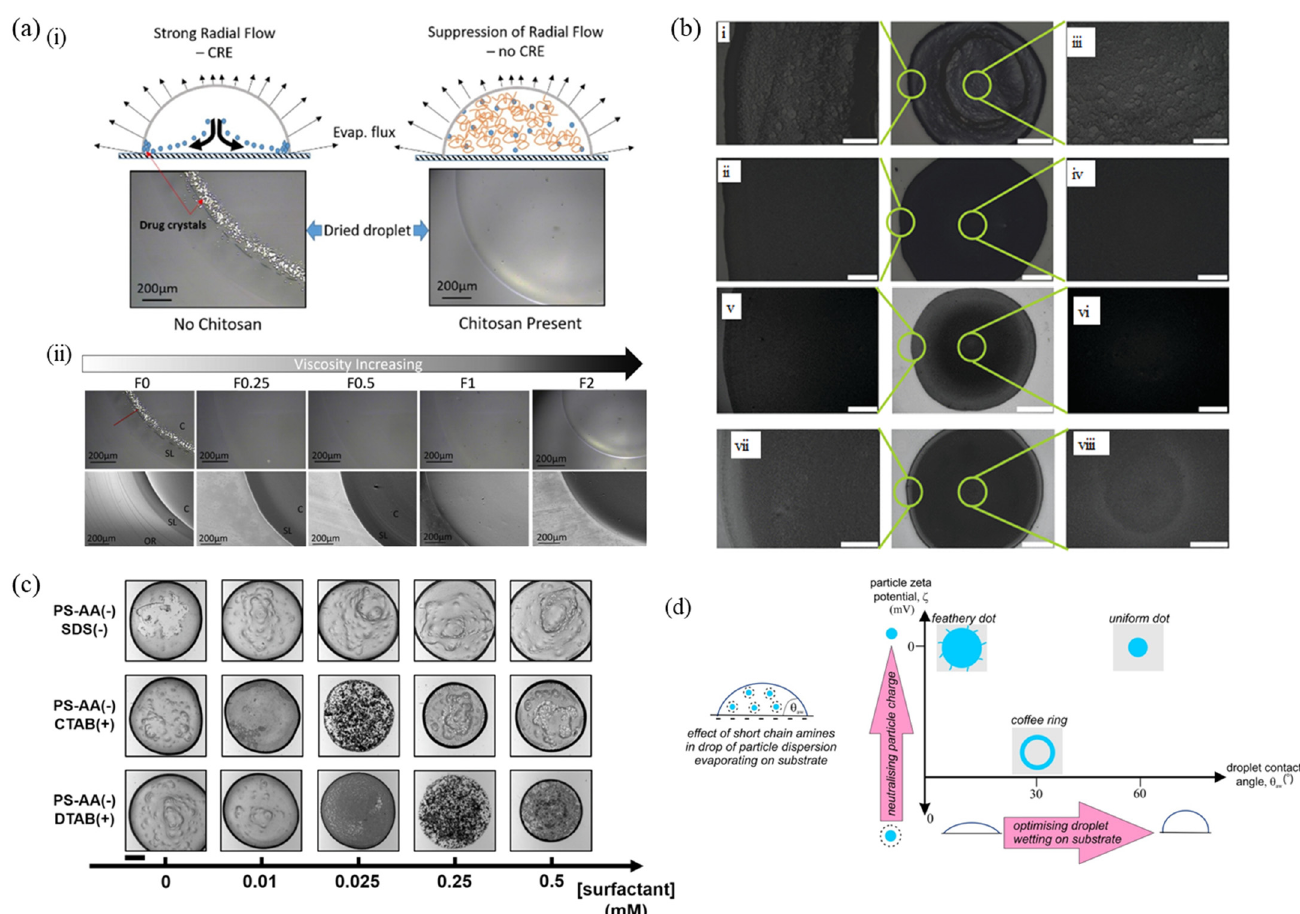
Figure 2. ( a ) (i) Drying process and final pattern of an aqueous droplet of paracetamol with/without chitosan polymer and (ii) Polarising light microscopy/PLM (top) and SEM (bottom) images of final deposition patterns at the center (C), stagnation line (SL) and outer ring (OR) regions at different chitosan-based formulations, 0, 0.25, 0.5, 1 and 2% ( w / w ) respectively (reproduced with permission from ref. [121]. Copyright 2021 AIP Publishing). ( b ) Magnification optical microscope images of SiO 2 microspheres at droplet edge (i) without PEO1 and (ii) with PEO1 additives; at droplet center (iii) without PEO1 and (iv) with PEO1 additives; with PEO2 additives (v) at droplet edge and (vi) center; and with PVA additives (vii) at droplet edge and (viii) center. The scale bar is 250 µ m for (i–viii), and 1 mm for the middle optical microscope images (reproduced with permission from ref. [55]. Copyright 2012 American Chemical Society). ( c ) Microscopic images of deposits formed from evaporating droplets (0.8 µ L) of mixtures of anionic PS particles (PS-AA, 500 nm diameter, 2 mg/mL) with surfactants (SDS, CTAB, and DTAB) at various concentrations (scale bar is 500 µ m) (reproduced with permission from ref. [43] Copyright 2015 American Chemical Society). ( d ) The effect of short-chain amine adsorption on the silica nanoparticles dispersed in a drop evaporating on a substrate (reproduced with permission from ref. [128]. Copyright 2020